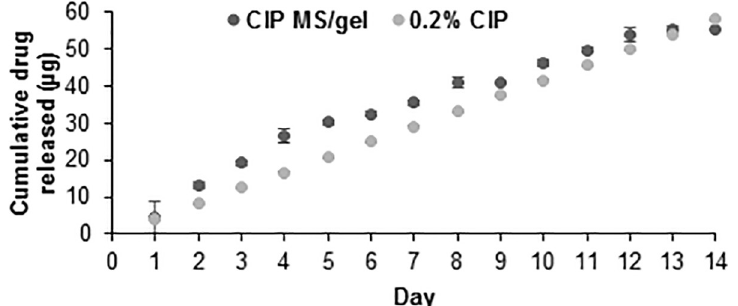
Fig 5. Ex vivo permeability of ciprofloxacin. Ex vivo permeability results showing transtympanic release from gel-MS system and standard twice-daily topical drops (0.2% ciprofloxacin), scaled to guinea pig ear canal volume [52] with reference to human ear canal volume [53–55]. Error bars represent the average ± standard error for n = 3 ears per time